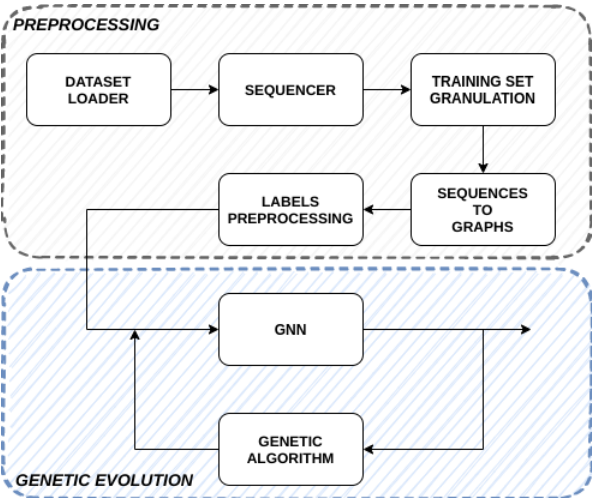
Figure 3. GNN optimization